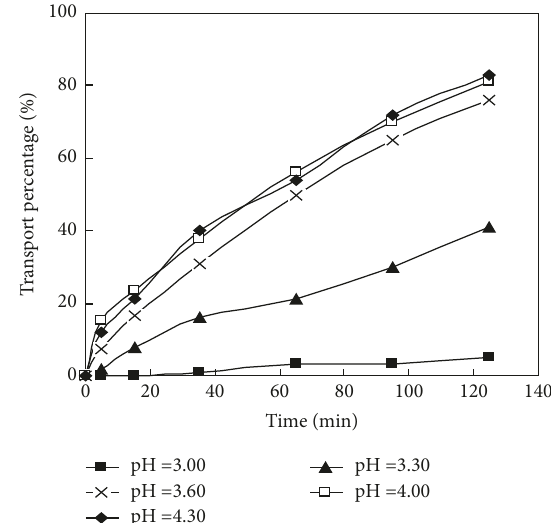
Figure 2: Effect of pH in feed phase on transport of La